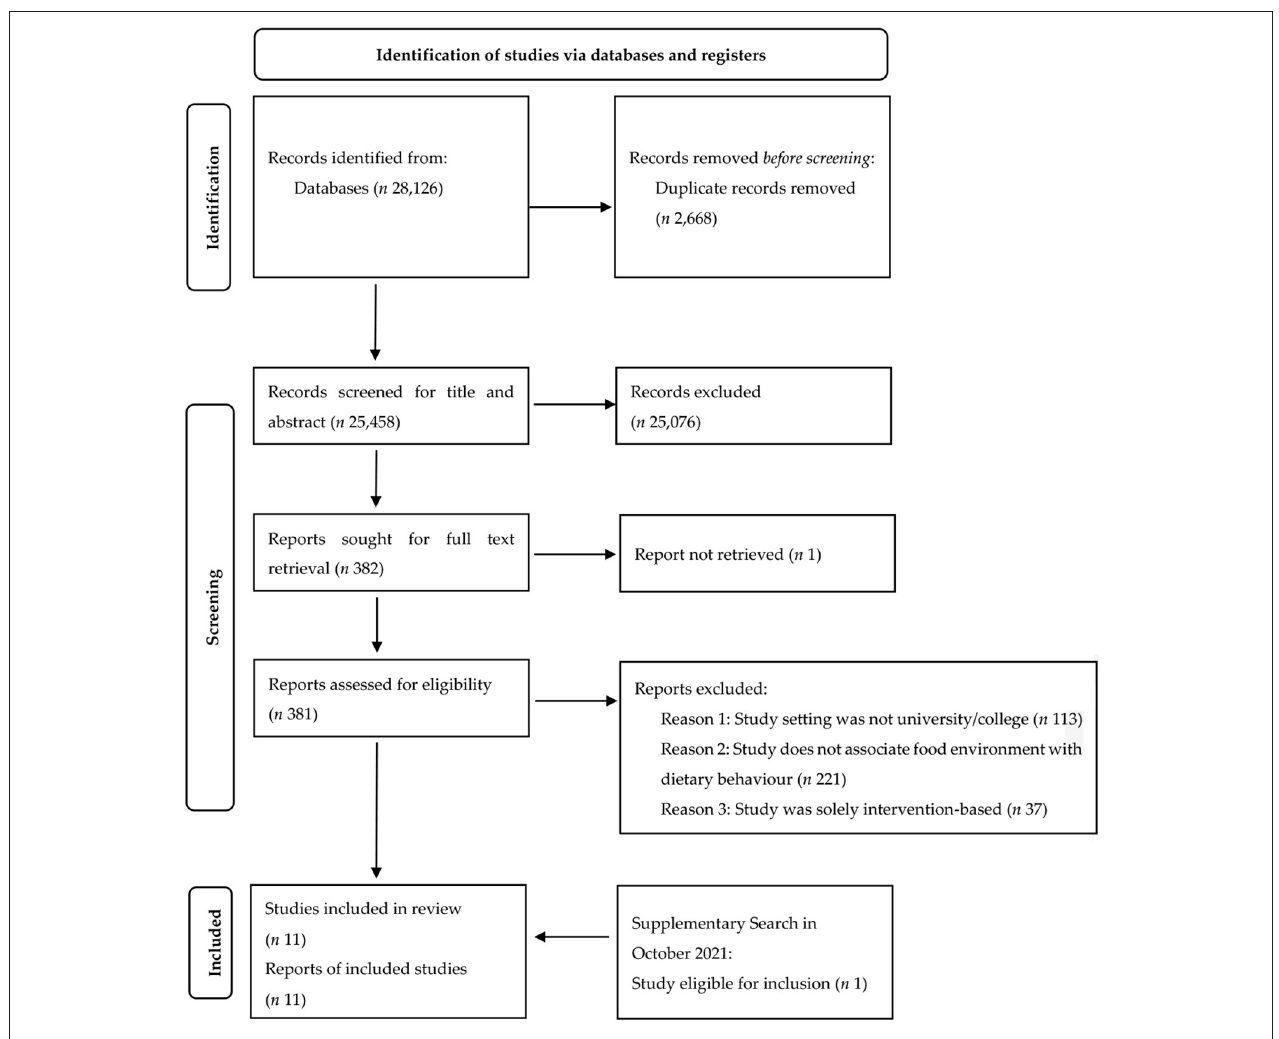
FIGURE 1 | Flowchart of literature search and selection